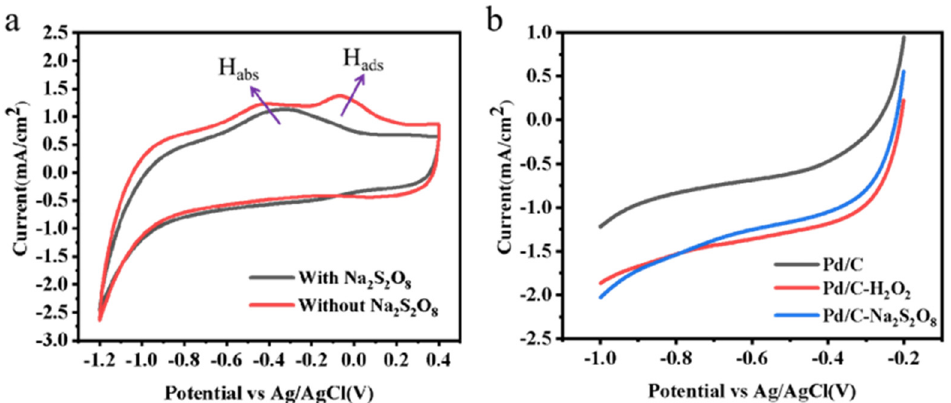
Figure 3. ( a ) CV measurement with Pd/C catalysts in 50 mM Na 2 SO 4 solution in absence or presence of Na 2 S 2 O 8 (Na 2 S 2 O 8 , 10 mM; solution pH, 7.0; scanning rate, 50 mV/s); ( b ) LSV of Pd/C catalyst with Na 2 S 2 O 8 or H 2 O 2 in 50 mM Na 2 SO 4 solution (Na 2 S 2 O 8 , 10 mM; H 2 O 2 , 10 mM; solution pH, 7.0; scanning rate, 50 mV/s).